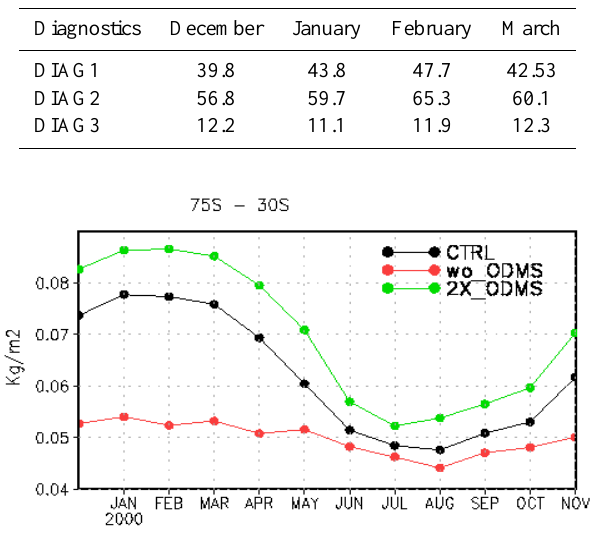
Fig. 4. Same as Fig. 2, but, for, the cloud liquid water path (Kg/m 2 ).